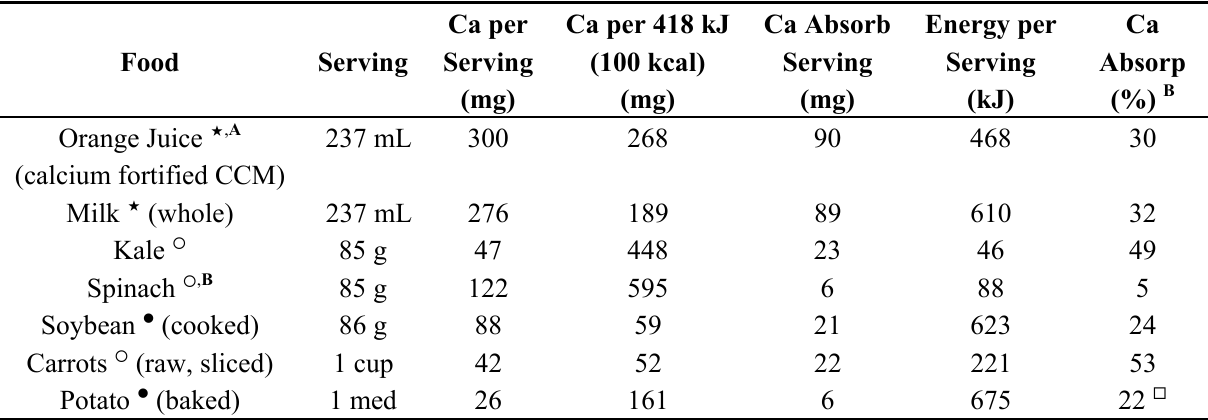
Table 1. Food sources of Calcium